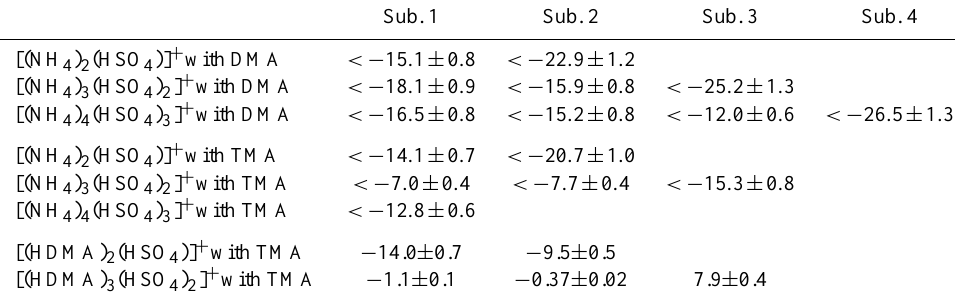
Table 2. 1G values (kJ/mol) for the substitution reactions of bisulfate clusters at